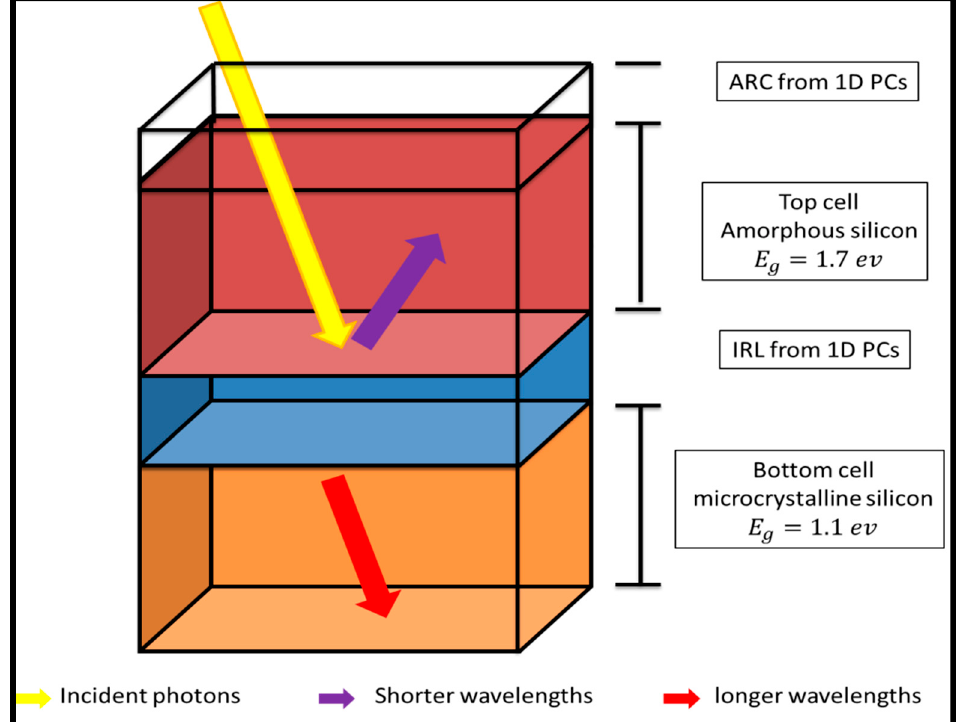
Figure 2. Schematic structure of tandem solar cell with anti-reflection coating and the intermediate reflective layer.